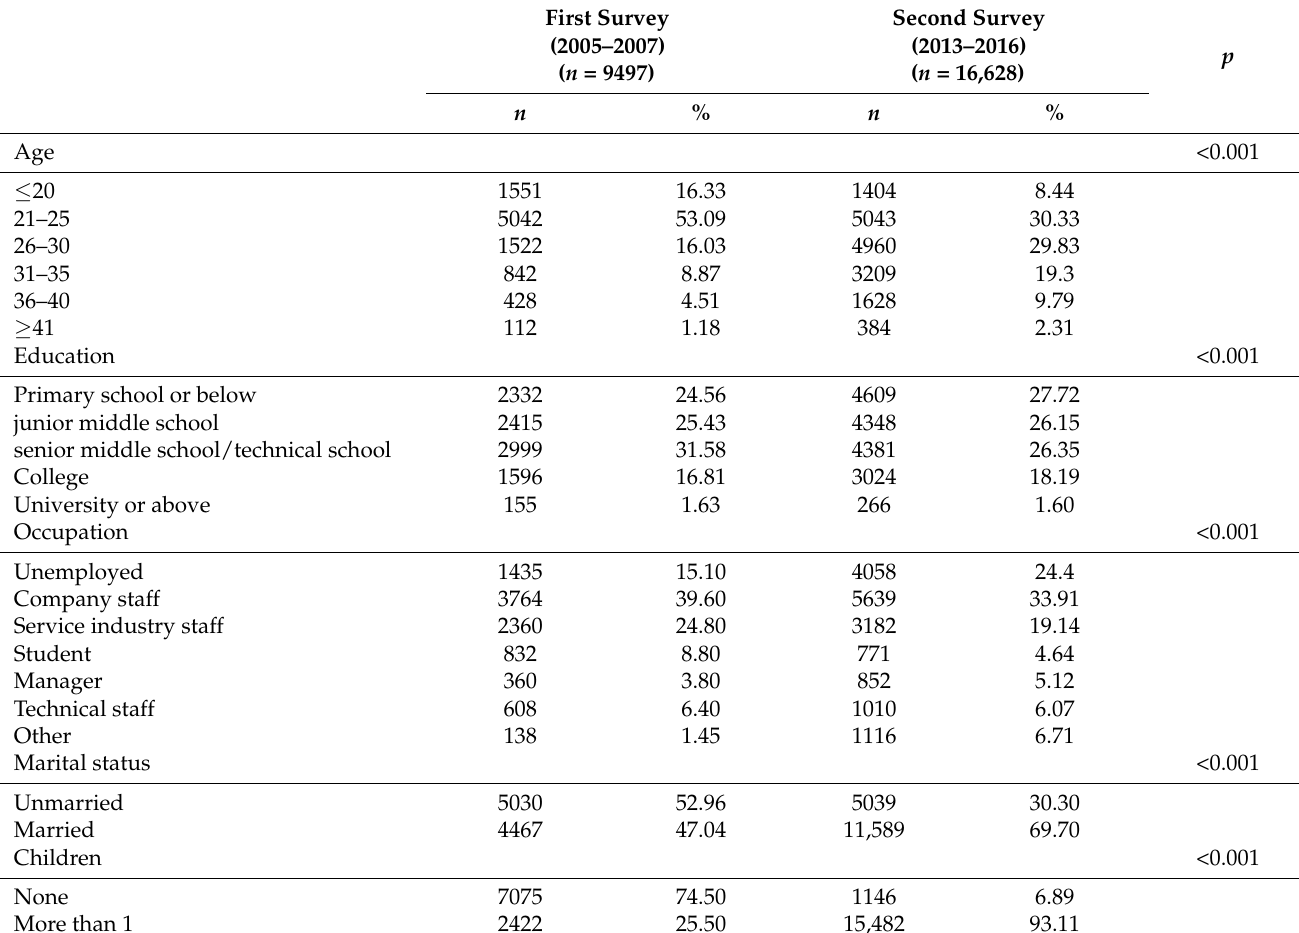
Table 1. Comparison of sociodemographic characteristics of women seeking induced abortion between two surveys.